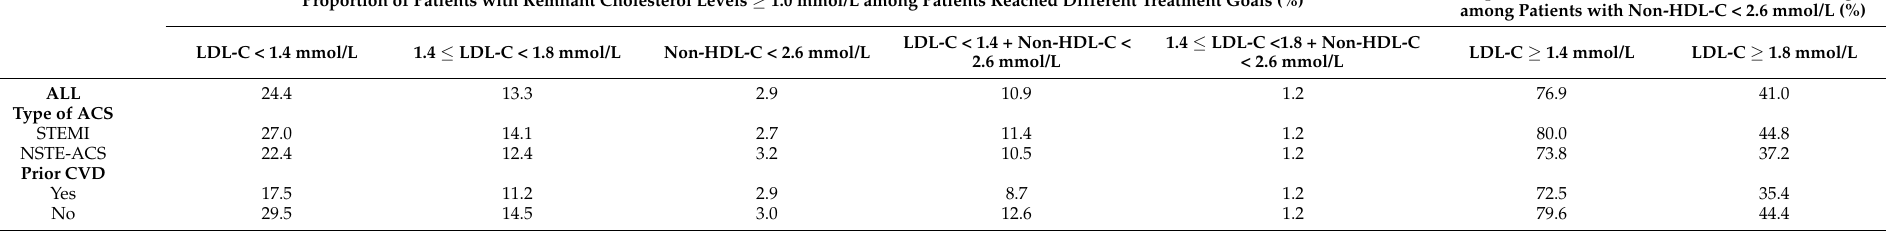
Table 2. Subgroup analysis of the proportion of patients with elevated remnant cholesterol or LDL-C concentrations in those who reached different treatment targets